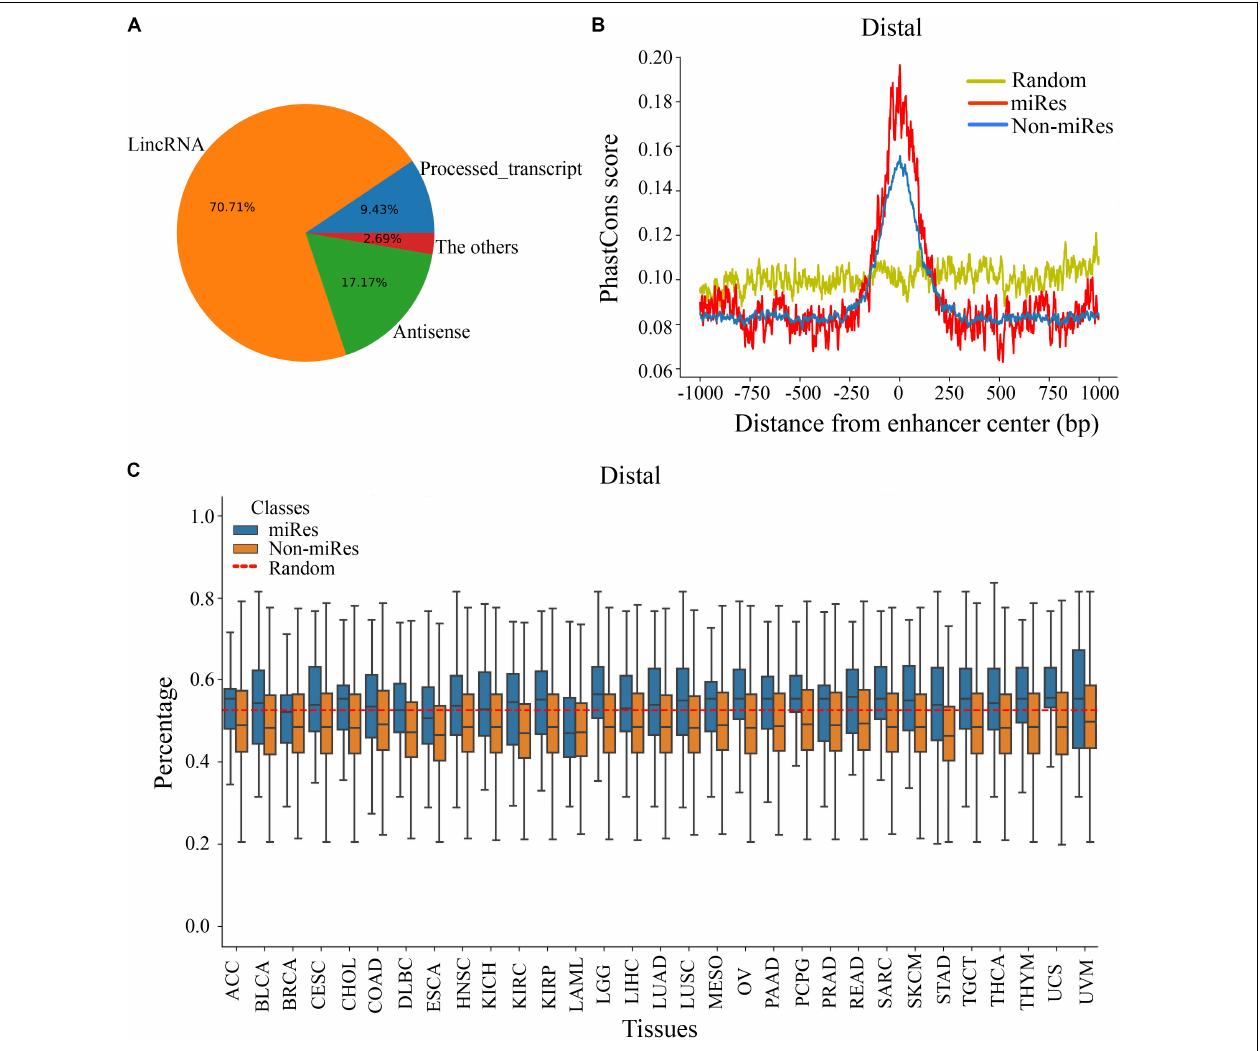
FIGURE 3 | There are significant differences in the sequence characteristics of miRes. (A) Pie chart of all enhancer transcripts in distal regulation. (B) Conservative score of the enhancer sequence using PhastCons in distal regulation. (C) GC content of the enhancer in distal